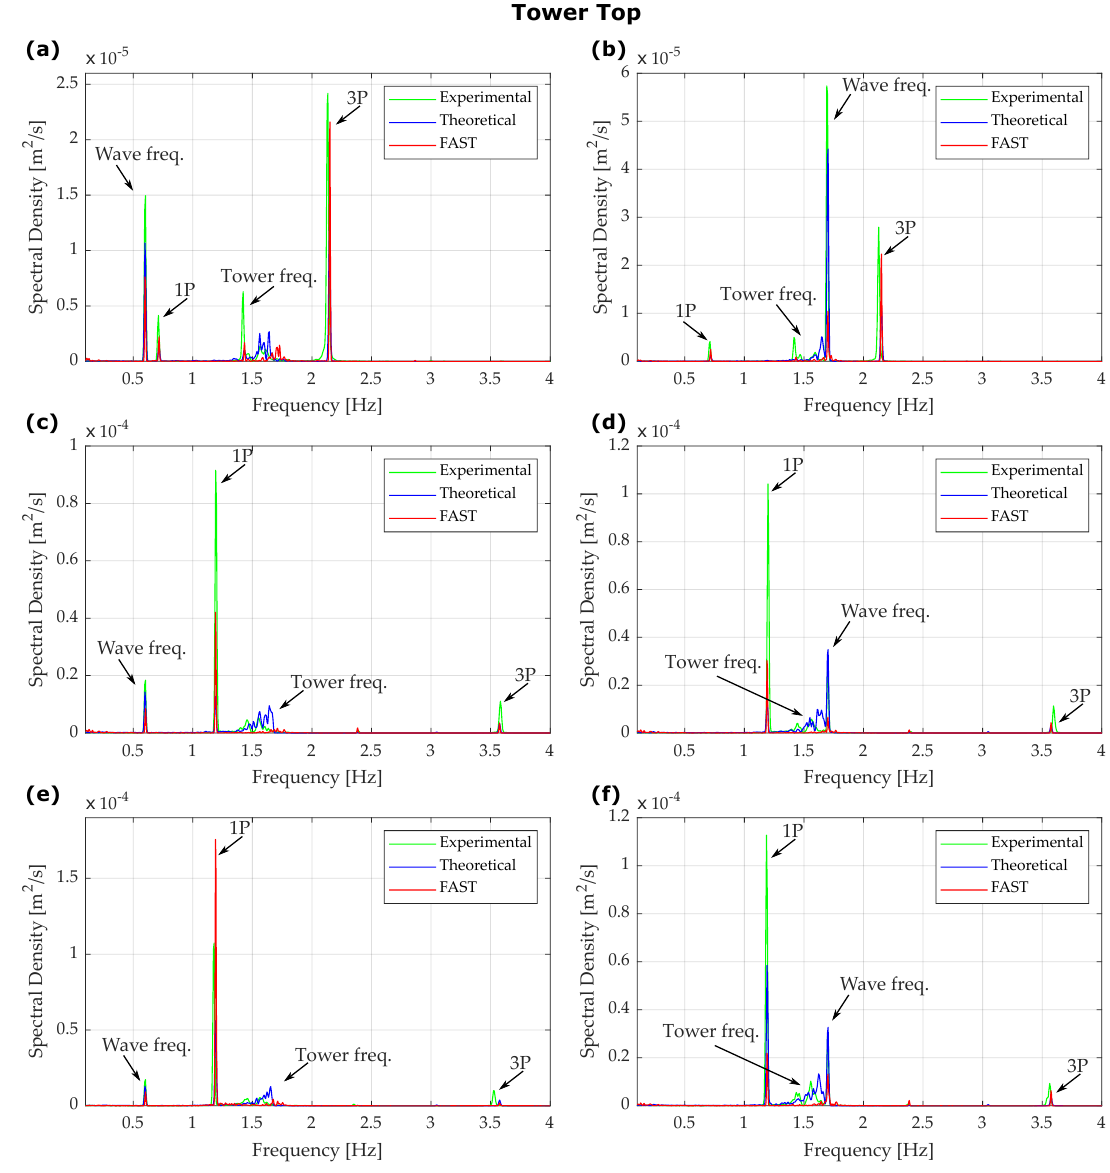
Figure 13. The PSD of the displacement time series of the tower top in surge from experiments and simulation by FAST and the theoretical model under different aerodynamic and hydrodynamic loading conditions. The waves are monochromatic with an amplitude which is set to 0.01 m. ( a ) Wave frequency set to 0.6 Hz and wind speed set to 4 m/s. ( b ) Wave frequency set to 1.7 Hz and wind speed set to 4 m/s. ( c ) Wave frequency set to 0.6 Hz and wind speed set to 7 m/s. ( d ) Wave frequency set to 1.7 Hz and wind speed set to 7 m/s. ( e ) Wave frequency set to 0.6 Hz and wind speed set to 8.6 m/s. ( f ) Wave frequency set to 1.7 Hz and wind speed set to 8.6